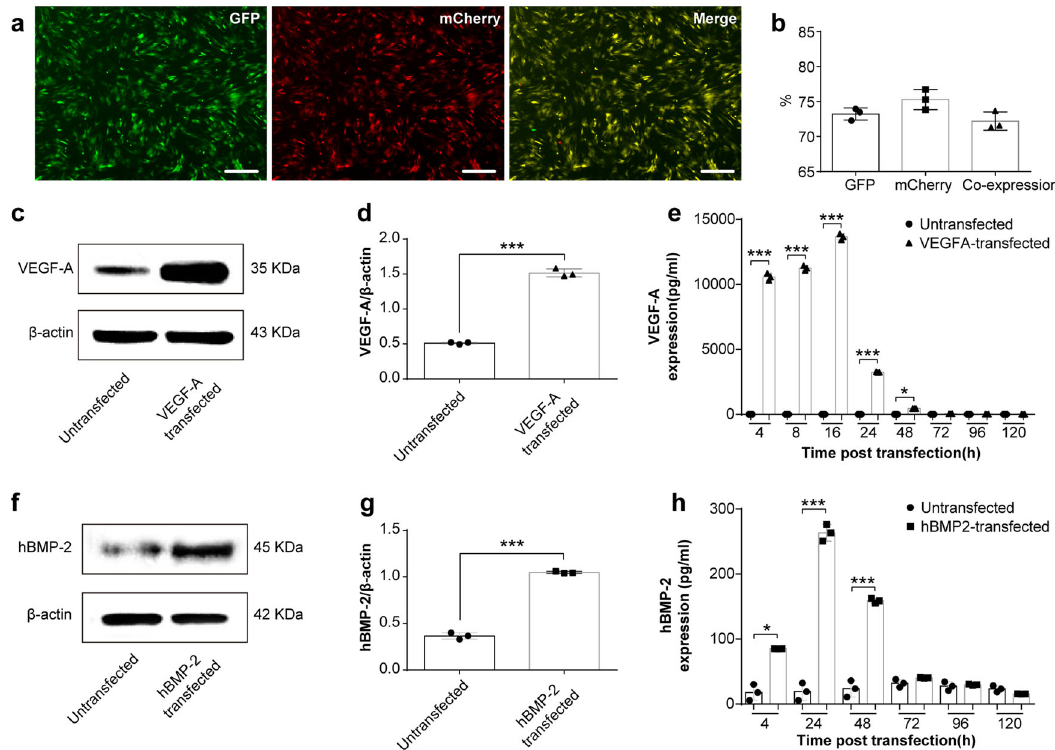
Fig. 1 Ef fi ciency and protein kinetics of modRNA transfection in BMSCs. a Representative fl uorescence microscopy images of BMSCs taken 24 h after GFP and mCherry modRNA co-transfection. The scale bars represent 250 μ m. b Flow data analysis depicted as a histogram revealing ef fi ciency of co- transfections. ( c – d , f , g ) Comparison of VEGF-A ( c – d ) or BMP-2 ( f , g ) protein expression between naïve BMSCs and modRNA-transfected BMSCs at 24 h post transfection. e , h VEGF-A ( e ) or hBMP-2 ( h ) protein expression kinetics at indicated times following modRNA transfections. Data results are expressed as mean ± SD, n = 3, * p < 0.05, ** p < 0.01, *** p < 0.001. (* p < 0.05) Indicate difference on secreted hBMP-2 or VEGF-A between untreated and transfected